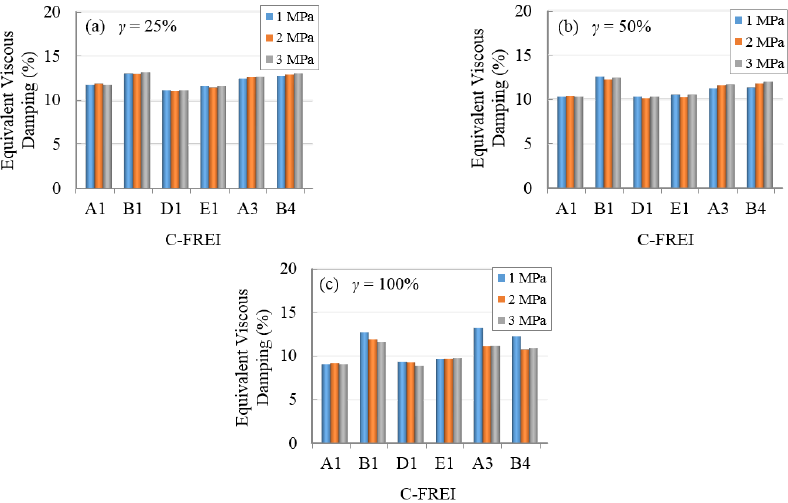
Figure 9. Equivalent viscous damping of C-FREIs under different vertical pressures (1, 2, and 3 MPa) and shear strains of ( a ) 25%; ( b ) 50%; and ( c ) 100%.